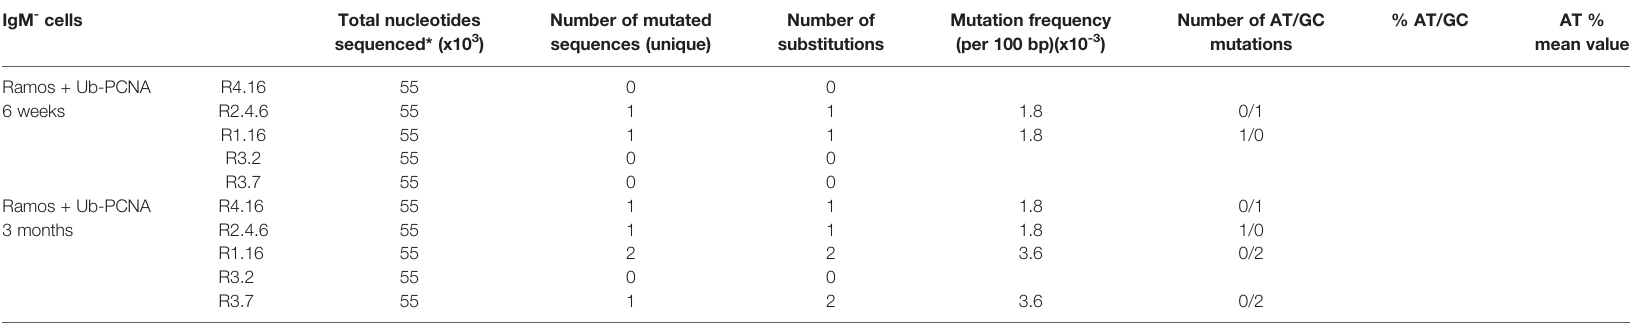
Number of Mutation frequency substitutions (per 100 bp)(x10 -3 )